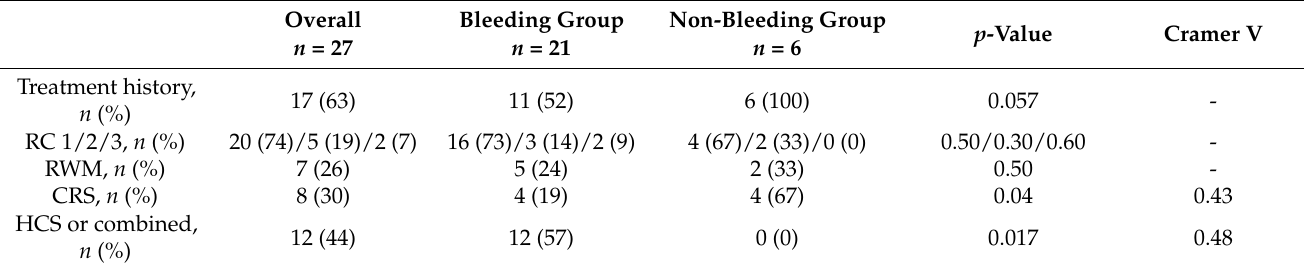
Table 3. Bleeding-associated factors in the follow-up group: Endoscopic